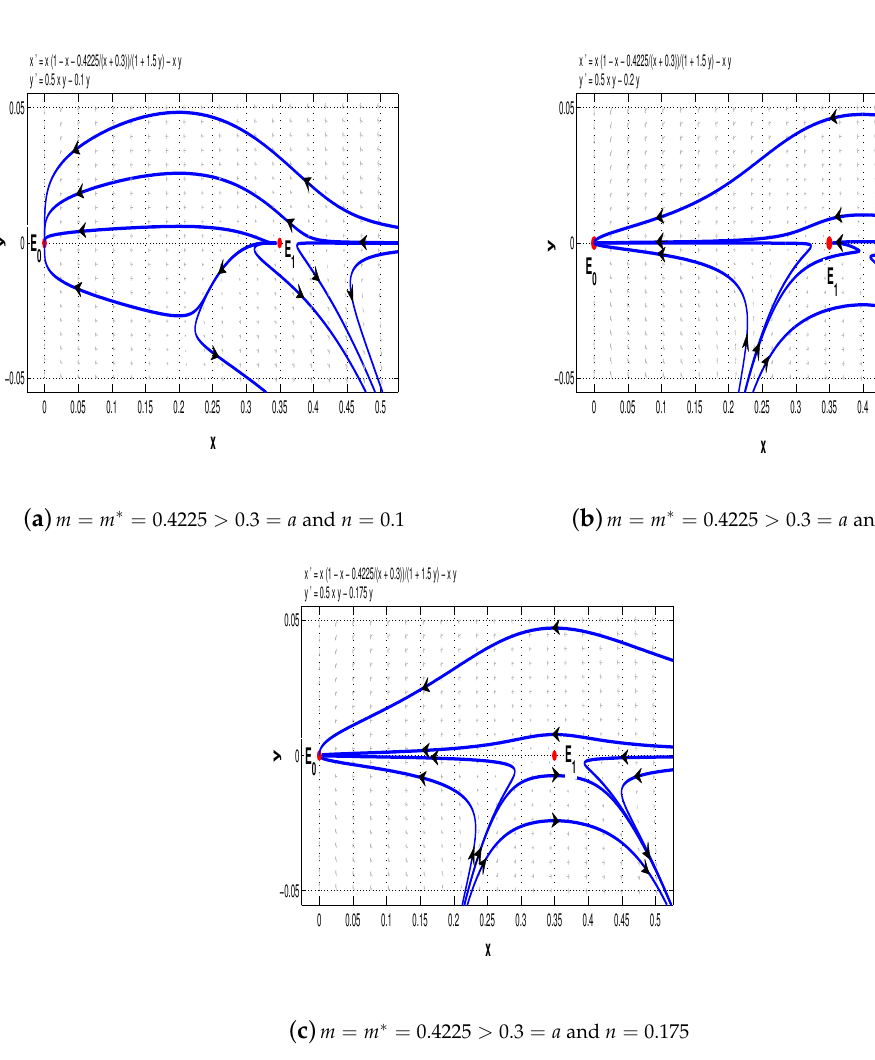
Figure 8. ( a ) When m = m ∗ = 0.4225 > 0.3 = a and n = 0.1, E 0 is a stable node and E 1 is a saddle-node. ( b ) When m = m ∗ = 0.4225 > 0.3 = a and n = 0.2, E 0 is a stable node and E 1 is a saddle-node. ( c ) When m = m ∗ = 0.4225 > 0.3 = a and n = 0.175, E 0 is a stable node and E 1 is a